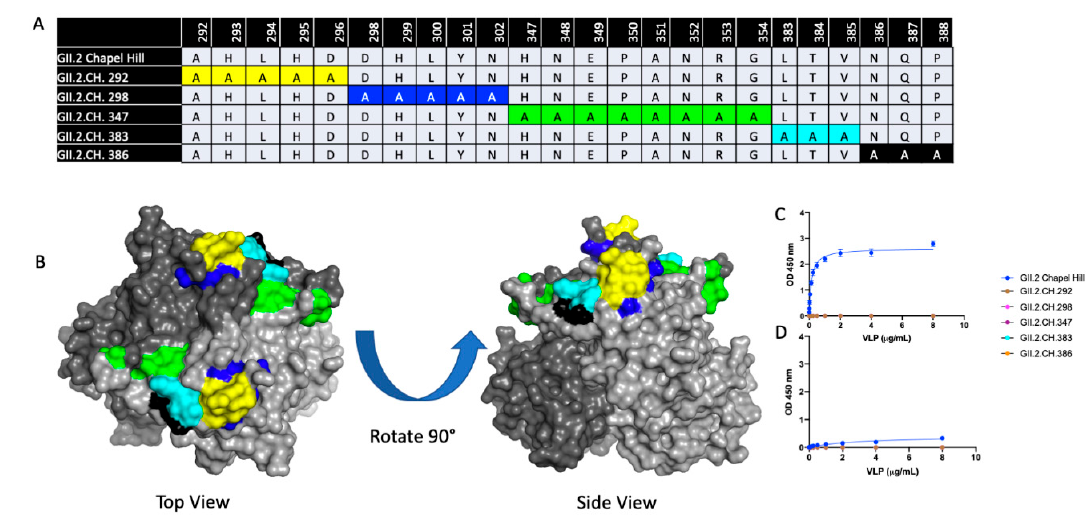
Figure 5. Characterization of GII.2 Chapel Hill Alanine mutant VLPs. ( A ) A panel of 5 alanine mutant VLPs were constructed comprising variable residues between GII.2 1976 SMV and GII.2 Chapel Hill within the P2 domain. Sequence alignments of variable residues within the 5 alanine mutants are compared against the Chapel Hill backbone. Color coordinated highlighted regions are highlighted on the GII.2 P domain dimer in ( B ). VLP binding to A and B saliva ( C , D ) were analyzed via one-site specific binding curve, fitted with error bars representing standard error of the mean.